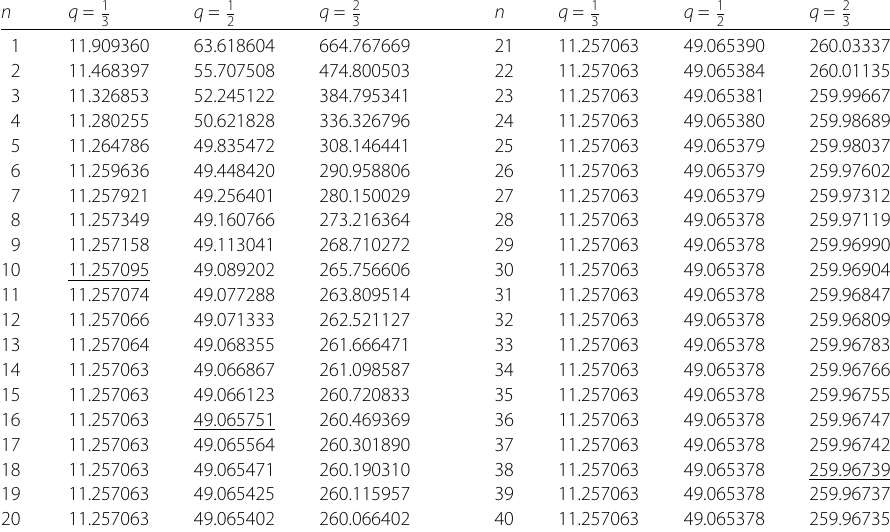
Table 3 Some numerical results for calculation of Γ q ( x ) with x = 8.4, q = 1